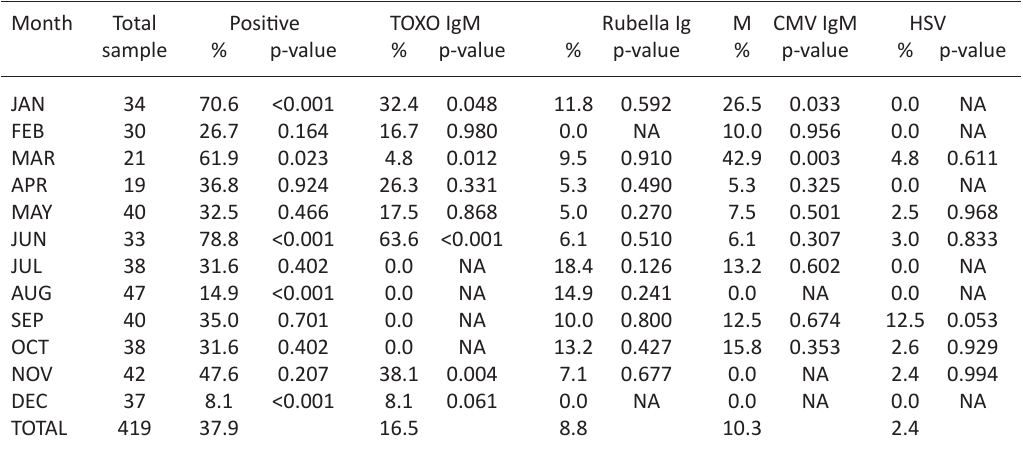
Table 1. Month wise seropositivity of torch infections